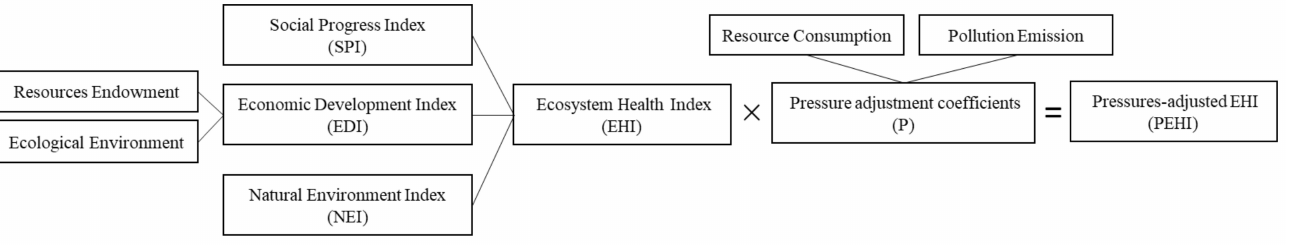
Figure 2. The hierarchical scheme of EHI and PEHI. Table 1. Index system of ecosystem health based on